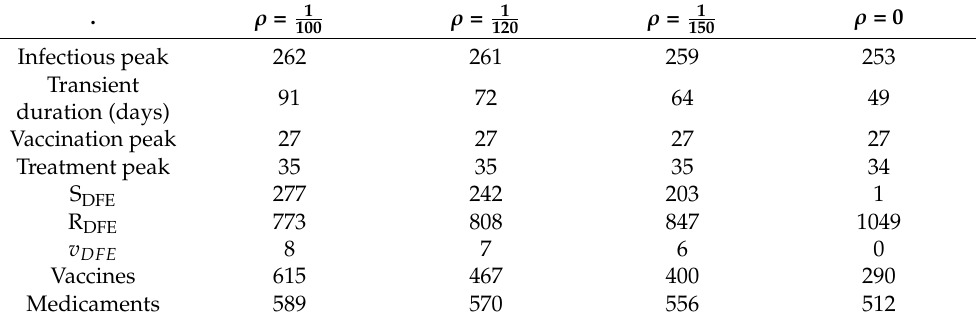
Table 5. Specifications of the model behaviour for the four considered values of the parameter ρ . . ρ = 1 ρ = 1 100